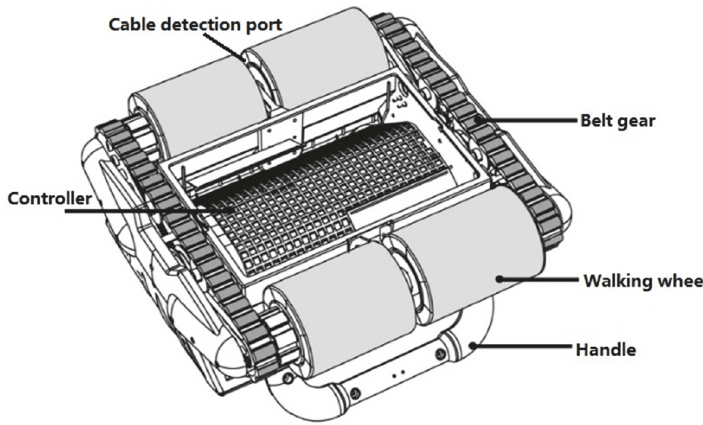
Figure 1: The structure of the cable detection underwater Robot.